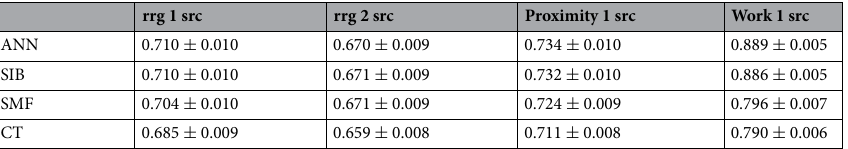
Table 1. Epidemic risk assessment results. Area under the Receiving Operating Characteristic (ROC) curves for the risk assessment problem on random regular graphs ( rrg ) with 1 and 2 sources, on the proximity random graphs and work real-world contact network. The results are averaged over 100 different epidemic cascades generated with the same epidemic parameters. For each case, the ROC curve for the classification of the unobserved infected individuals at the final time is computed. In the rrg case, the epidemic parameters are (cid:31) ( 1 ) 0.035 for the single source and (cid:31) ( 2 ) 0.03 for the double source case. For the proximity random graphs, rrg = rrg = (cid:31) 0.03 . In the case of the work network, the model has rate of infection γ work = 10 − 3 . prox =